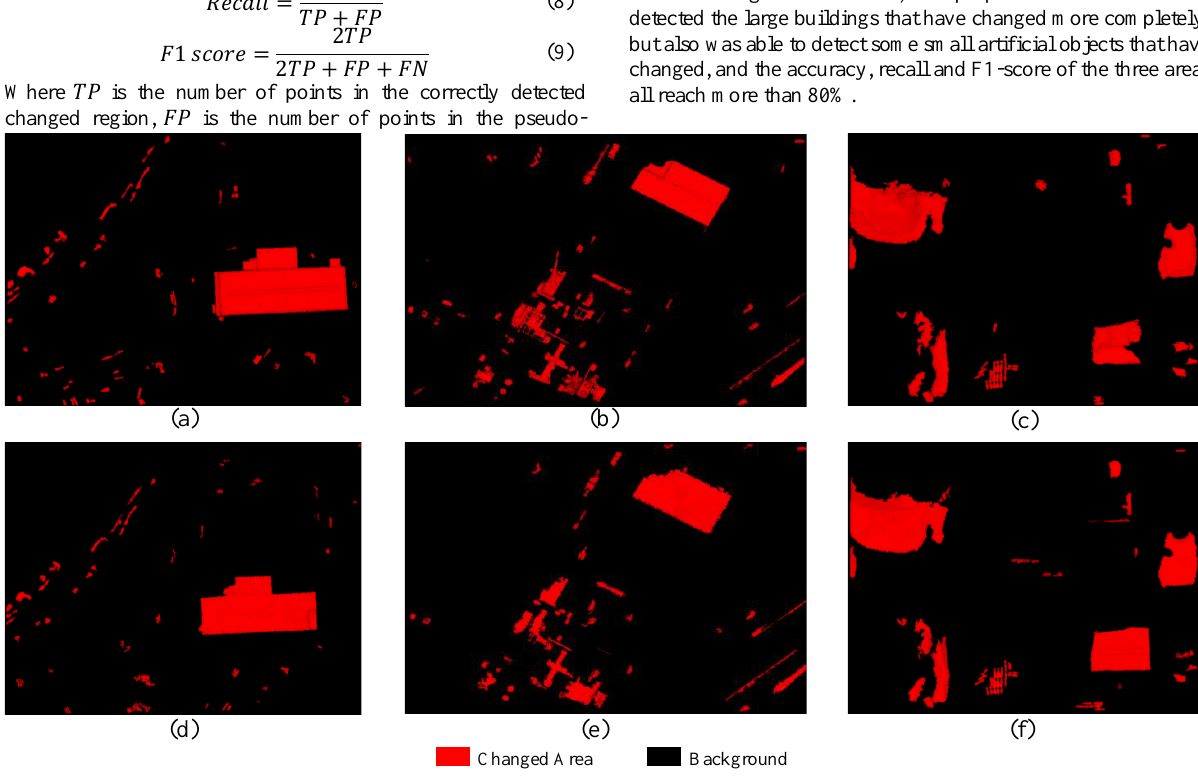
Figure. 5 3D change detection results used the proposed method: (a) is the change detection result of the first phase point clouds of area 1, (d) is the change detection result of the second phase point clouds of area 1, (b) is the change detection result of the first phase point clouds of area 2, (e) is the change detection result of the second phase point clouds of area 2, (c) is the change detection result of the first phase point clouds of area 3, (f) is the change detection result of the second phase point clouds of area